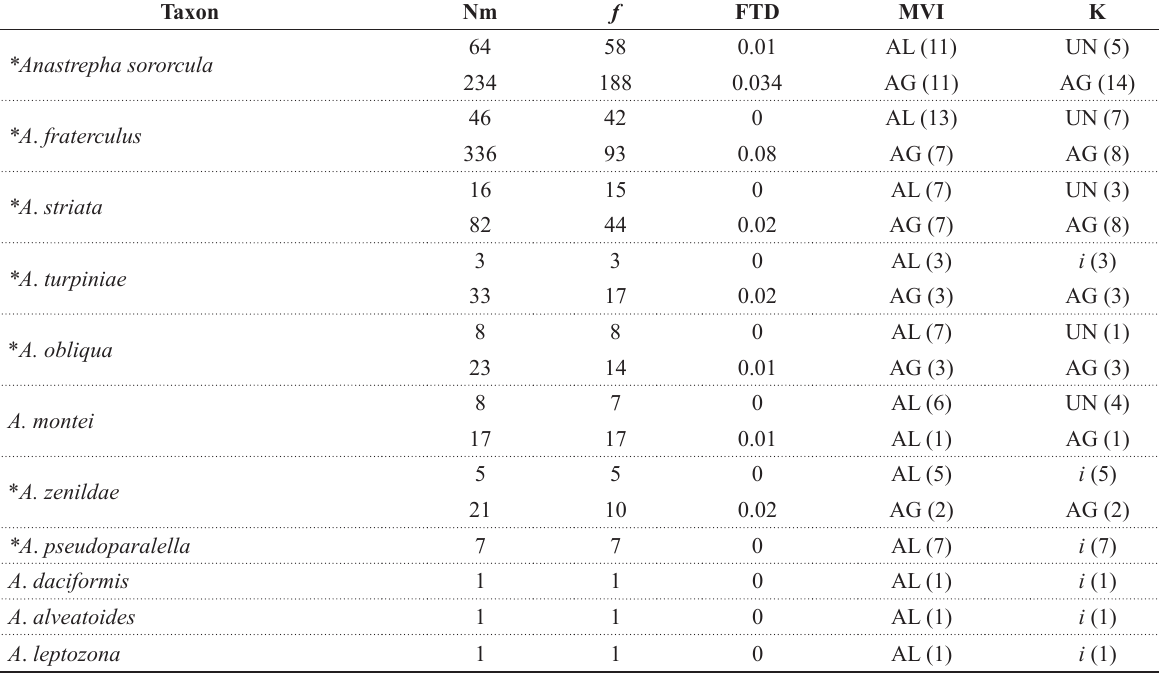
Aggregation index of adults of pest species of Anastrepha spp. (Diptera: Tephritidae) in guava orchards, Ivinhema, State of Mato Grosso do Sul (August 2013 to January